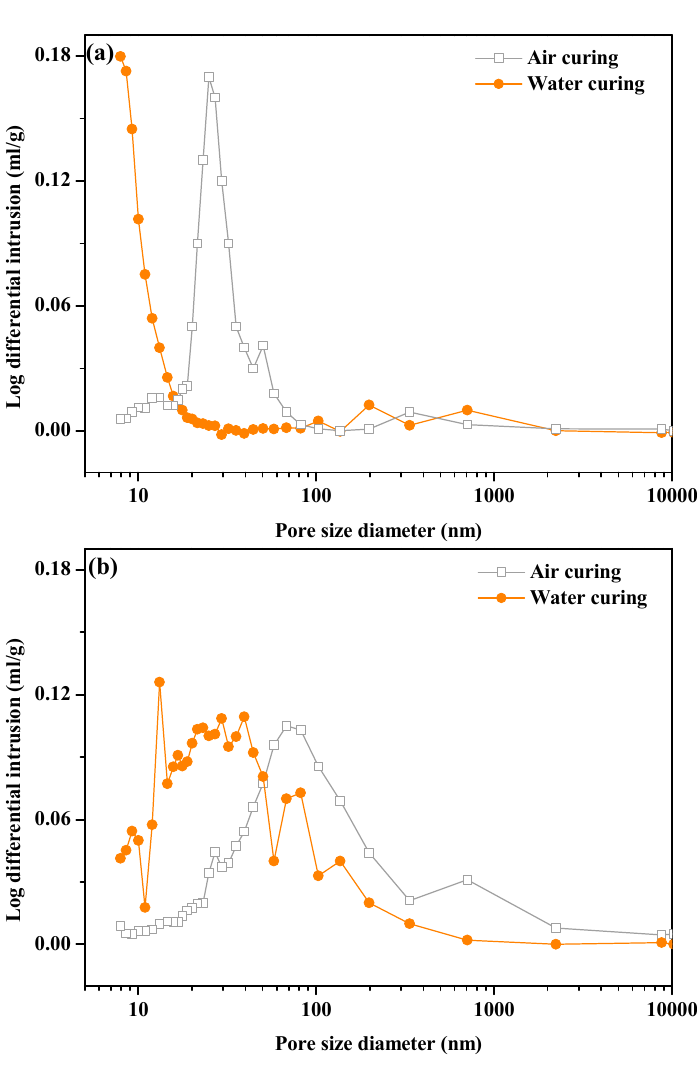
Figure 13. Comparison of cumulative intruded volume vs. pore diameter after 28 days of air curing and after water immersion for 28 days: ( a ) control and ( b ) SS30.